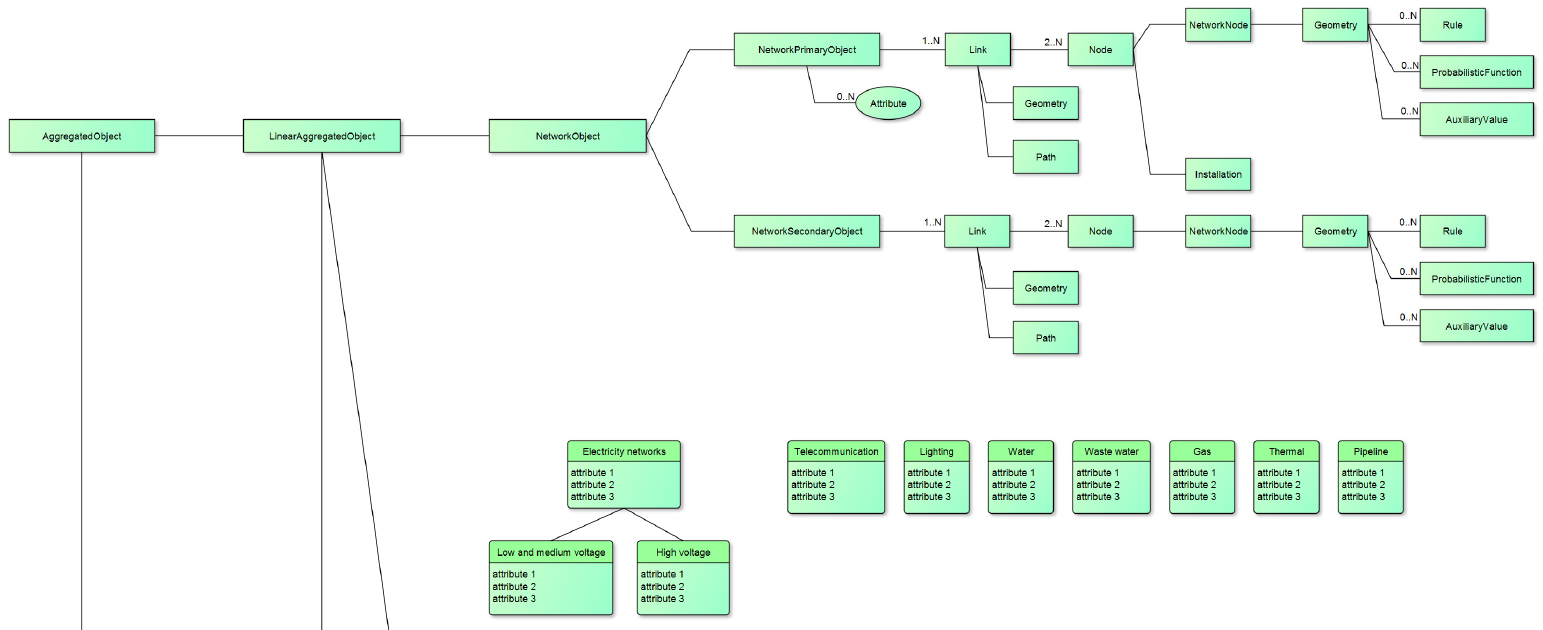
Figure A2. Utility networks, simplified minimal model.